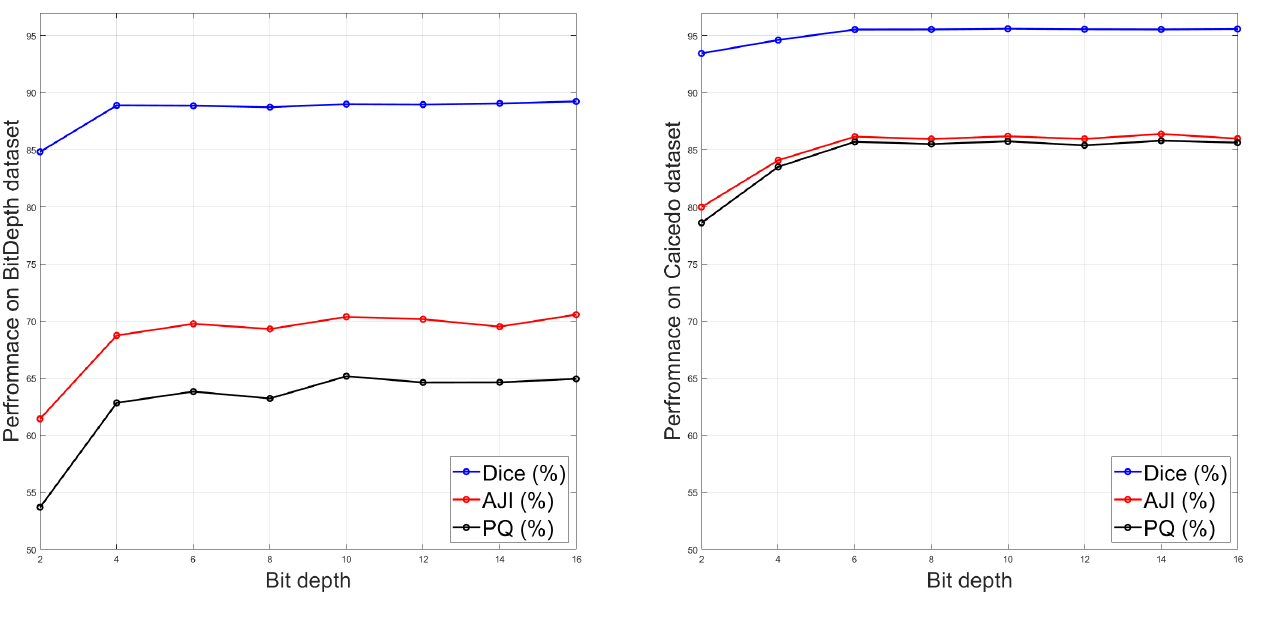
Figure 8. The average nuclei instance segmentation performance based on Dice, AJI and PQ scores for different image bit depths for the BitDepth and Caicedo et al.